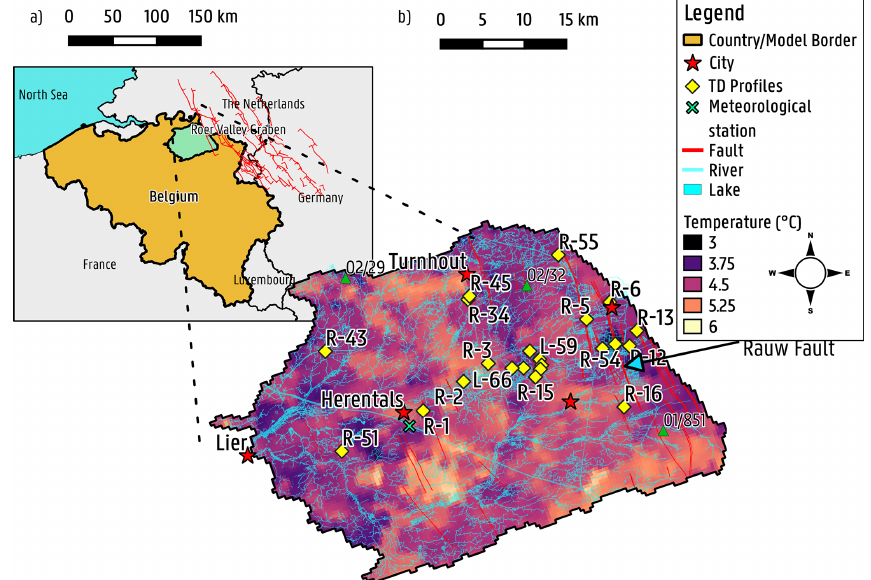
Figure 1. Geographical location of (a) the Nete catchment within Belgium with an indication of the faults in the Roer Valley Rift System, as in Vanneste et al. (2013), and (b) the land surface temperature averaged for January 2001 derived from satellite data (MODIS) for of the study area within the Nete catchment.